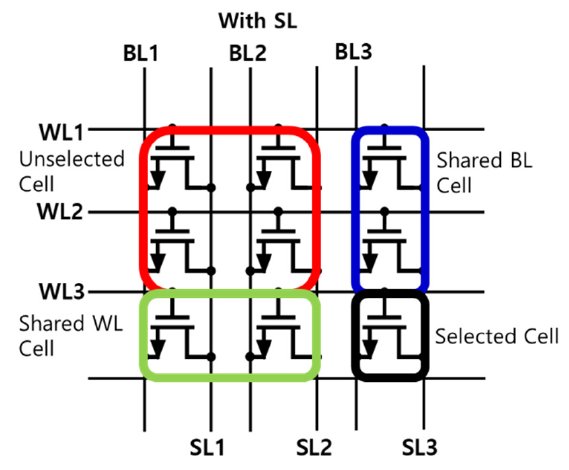
Figure 8. Array circuit structure and cell names used in second simulation.